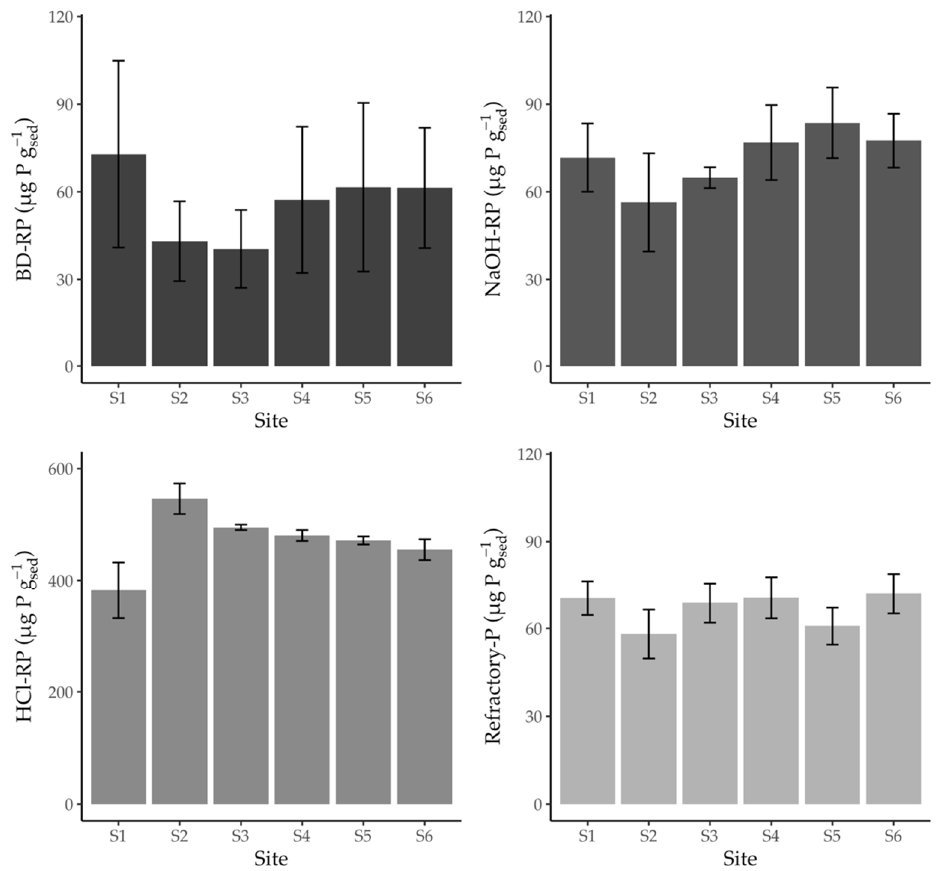
Figure 2. Distribution of particulate phosphorus (PP) forms in fine sediments stored in the gravel-bed of the Crowsnest River in 2016 and 2017 ( n = 4 per site). Error bars represent plus and minus one standard deviation from the average (height of the bar).